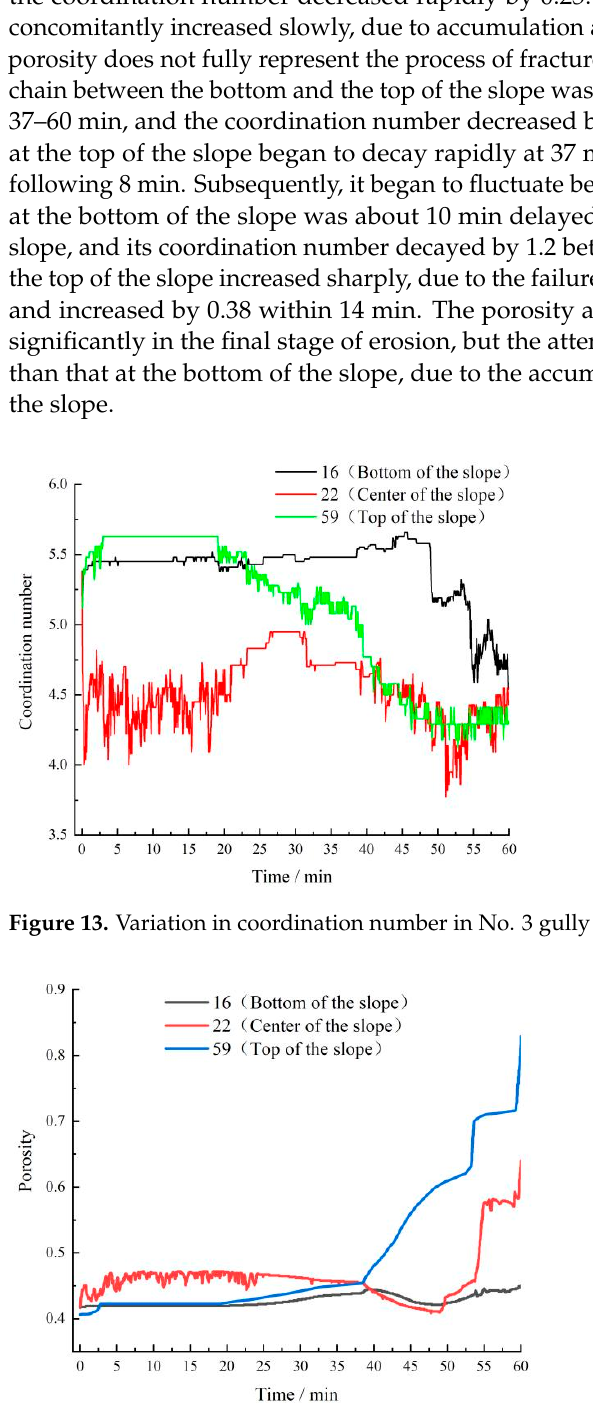
Figure 15. Overall slope peak porosity. To study the interaction and expansion of grains on both sides of the gully, we se- lected Sections A and C as case studies. Through the unbalanced force in the x-direction measured at the monitoring point, we obtained the force curve, as shown in Figure 16.